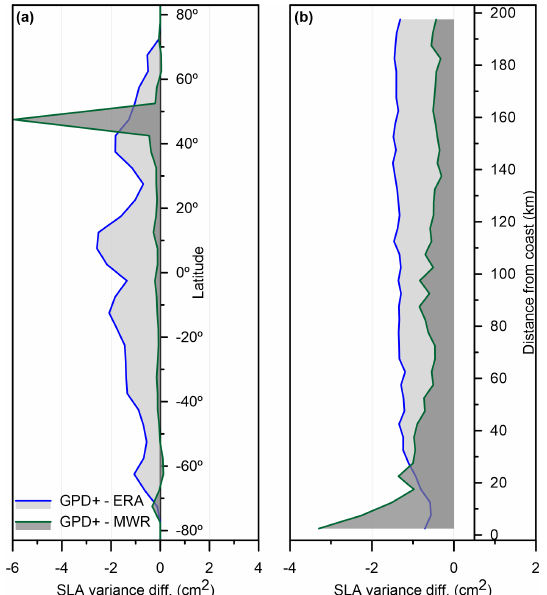
Figure 13. Variance differences (cm 2 ) of SLA versus latitude (a) and distance from the coast (b) between GPD + and ERA-Interim WTCs (blue) and GPD + and the MWR-derived WTCs (green) for Envisat cycles 6 to